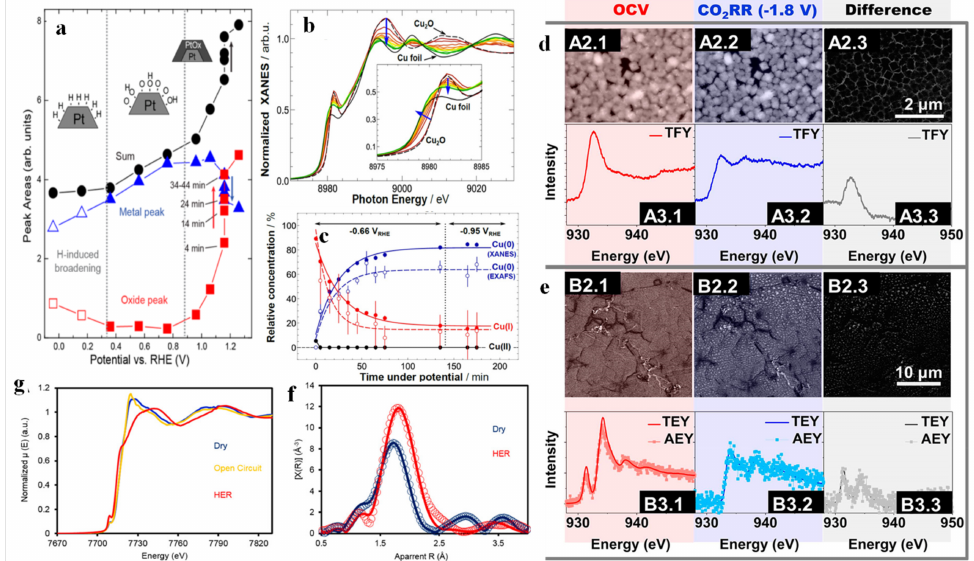
Figure 12. Areas of the fitted components for the full set of spectra acquired for S1, as well as their sum, plotted as a function of the sample potential ( a ). Adapted with permission from ref. [148]. Copyright 2012 American Chemical Society. Cu K-edge XANES data of U-NC sample acquired under operando CO 2 reduction conditions ( b ). Temporal evolution of the chemical composition of the Cu 2 O cubes during CO 2 electroreduction obtained from the linear combination analysis of XANES data (filled circles) and coordination numbers from EXAFS data fitting (empty circles). Solid and dashed lines are guides for the eye. ( c ). Adapted with permission from ref. [149]. Copyright 2020 John Wiley & Sons, Inc. A2: In situ ECSEM measurements in 100 mM KHCO 3 saturated in CO 2 under OCV and CO 2 RR; A3: In situ XAS measurements in TFY in 100 mM KHCO 3 saturated in CO 2 under OCV and − 1.8 V vs. Ag/AgCl ( d ); B2: In situ ECSEM measurements in 100 mM KHCO 3 saturated in CO 2 under OCV and CO 2 RR; B3: XAS measurements in TEY and AEY in 100 mM KHCO 3 under OCV and − 1.8 V vs. Ag/AgCl ( e ). Adapted with permission from ref. [150]. Copyright 2020 American Chemical Society. Operando Co K-edge XANES ( f ) reveals a line shape change that suggests transformation from cobalt oxide to cobalt sulfide. EXAFS ( g ) qualitatively indicates an increased average bond length and decreased shell contributions. Adapted with permission from ref. [151]. Copyright 2015 American Chemical